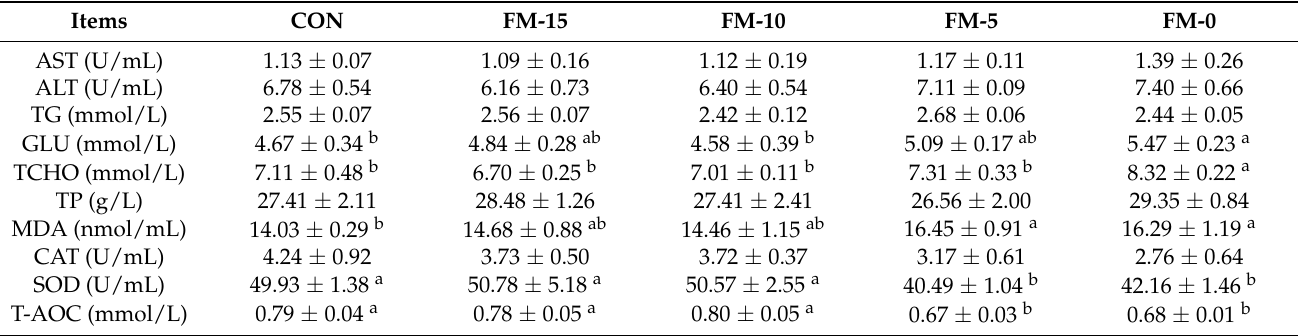
Table 6. Effect of replacing fishmeal with CPC and CAP mixture on serum biochemical indices of rainbow trout.